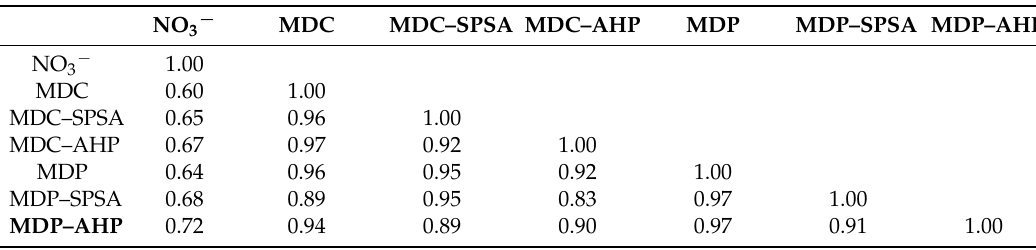
Table 9. Correlation coefficients between the various indexes of vulnerabilities and the nitrates (Boldface coefficients are significant for p <